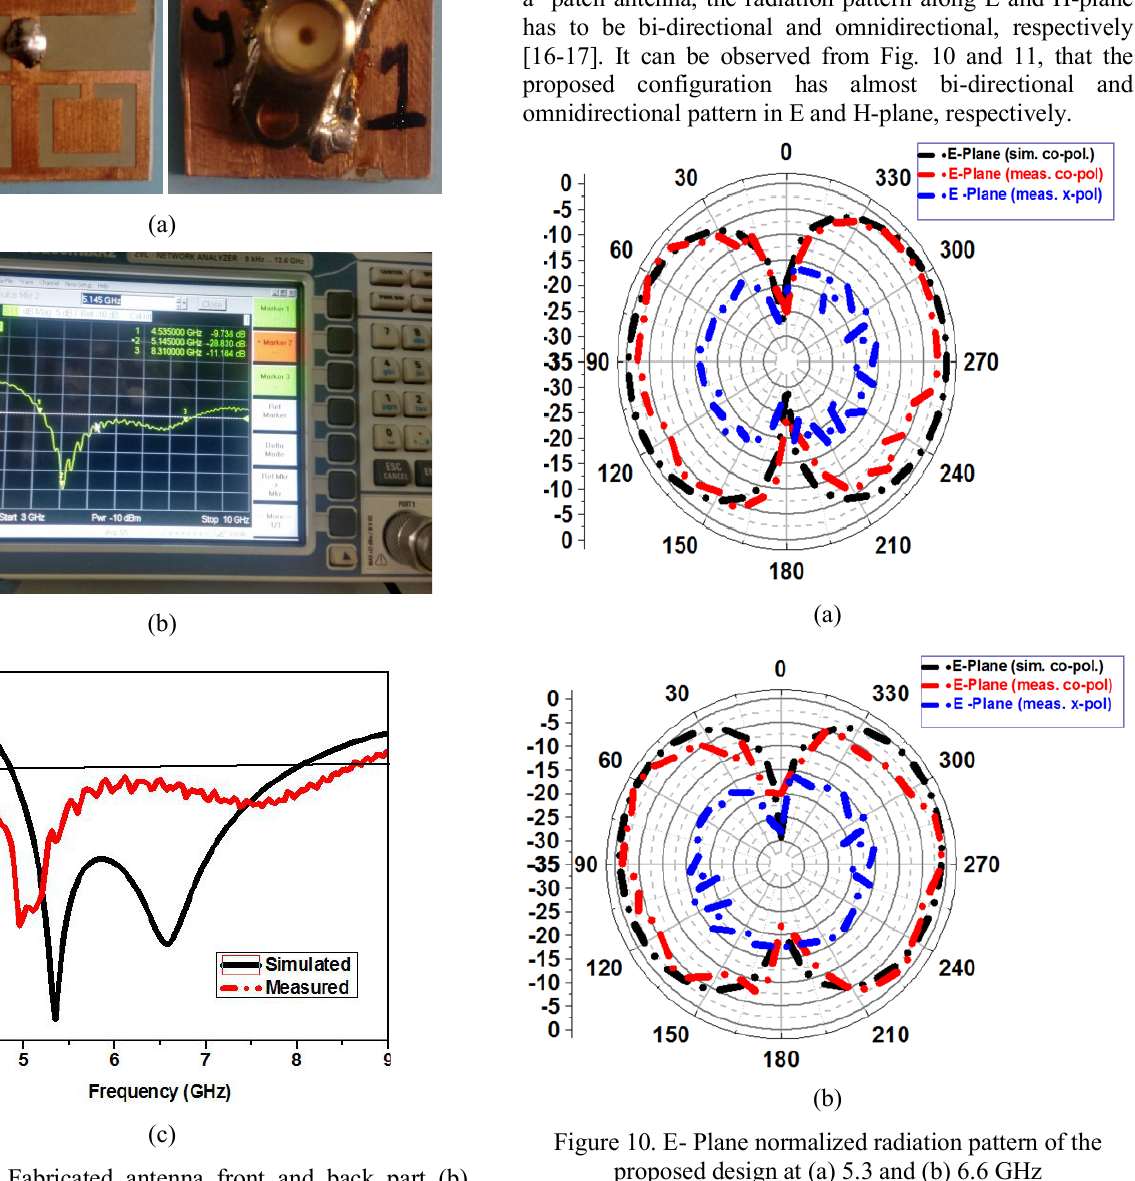
Figure 9. (a) Fabricated antenna front and back part (b) VNA set-up to measured S 11 (c) compared simulated and measured S 11 of the proposed antenna.